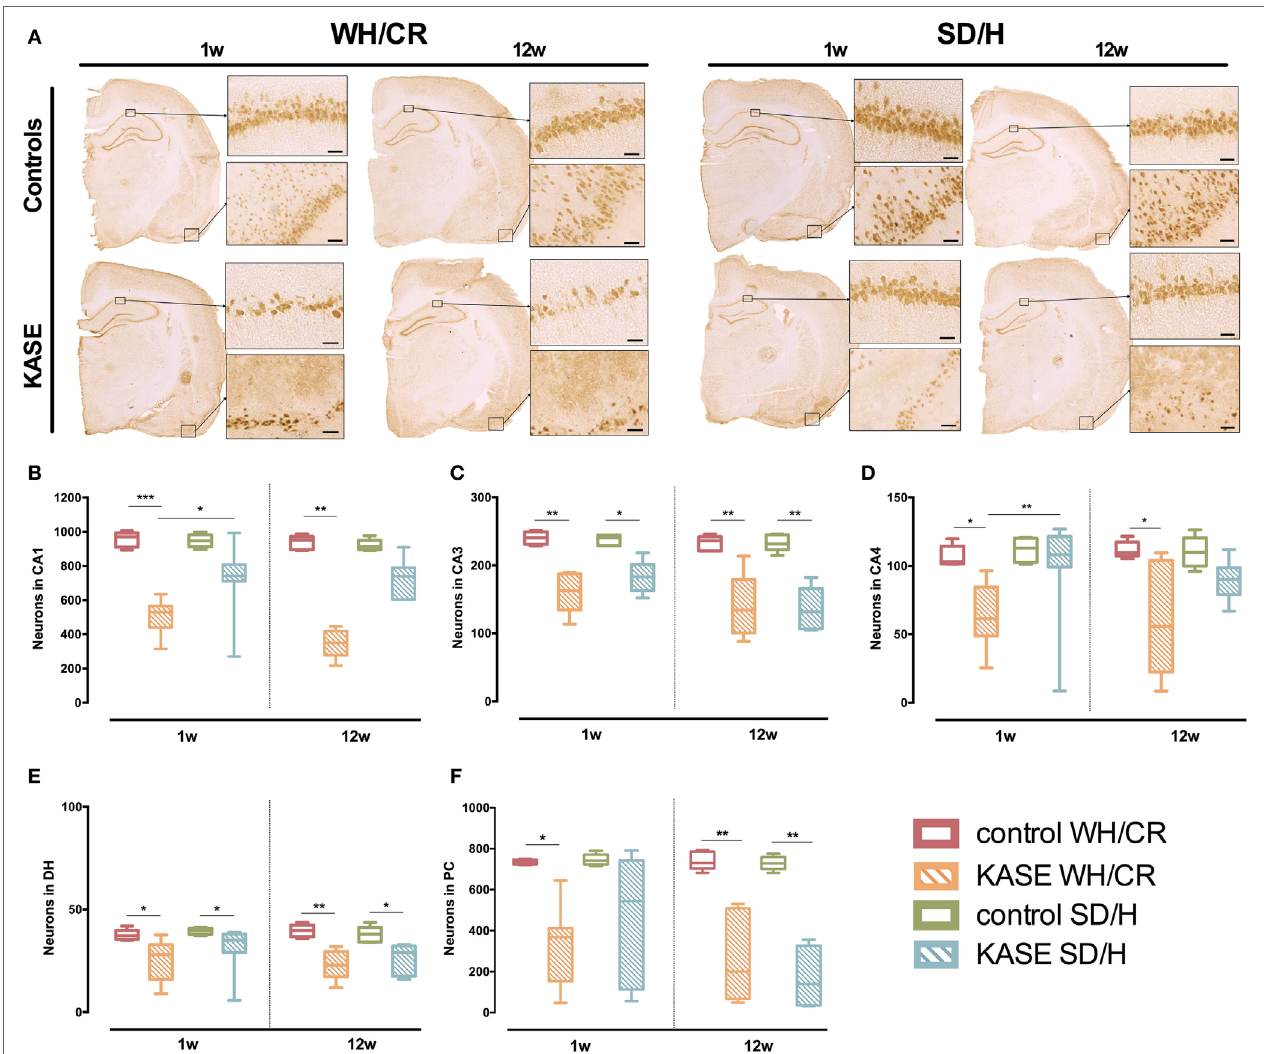
FigUre 4 | Neuronal loss in KASE WH/CR and KASE SD/H rats. (a) Representative KASE and control rats 1 and 12 weeks post-status epilepticus (SE). At both time points, a significant difference could be demonstrated for the investigated regions (B–F) between the respective control and KASE WH/CR animals, while for the SD/H animals only in CA3 and DH 1 week post-SE, and CA3, DH, and PC 12 weeks post-SE (c,e,F) . In addition, for the CA1 and CA4 sub-regions, significant higher neuronal loss could be demonstrated for the KASE WH/CR animals compared to KASE SD/H rats 1 week post-SE. Kruskal–Wallis test with post hoc Dunn’s test (B–F) . 1 week post-SE: control WH/CR n = 5, KASE WH/CR n = 10, control SD/H n = 5 and KASE SD/H n = 9; 12 weeks post-SE: control WH/CR n = 7, KASE WH/CR n = 6, control SD/H n = 6 and KASE SD/H n = 6. Insets were taken at 10 × magnification. Scale bar = 50 µm. * p < 0.05, ** p < 0.01. WH/CR, Wistar Han/Charles River; SD/H, Sprague-Dawley/Harlan; w, week; CA, cornu ammonis; DH, dentate hilus; PC, piriform cortex; KASE, kainic acid-induced status epilepticus